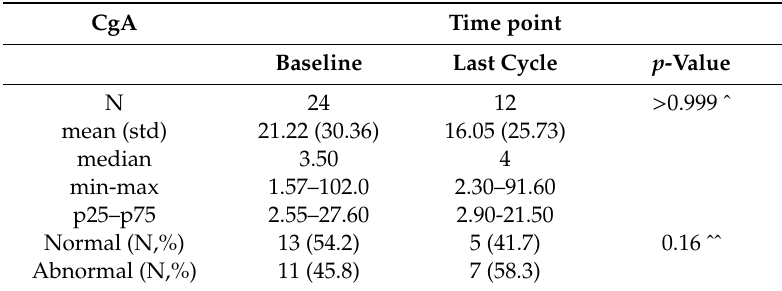
Table 2. The levels of CgA at baseline and at the last treatment